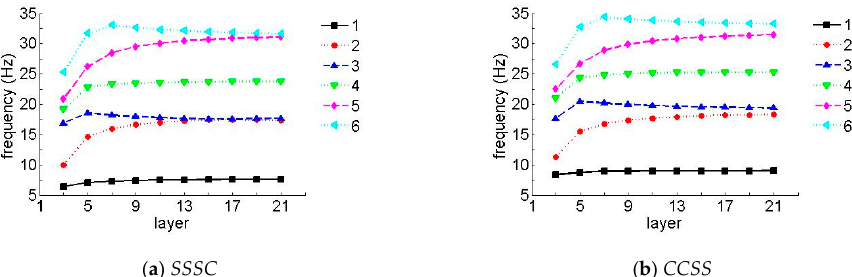
Figure 9. Natural frequency parameters for a laminate with arbitrary layers (laying angle = 90°). ( a ) SSSC, ( b ) CCSS.